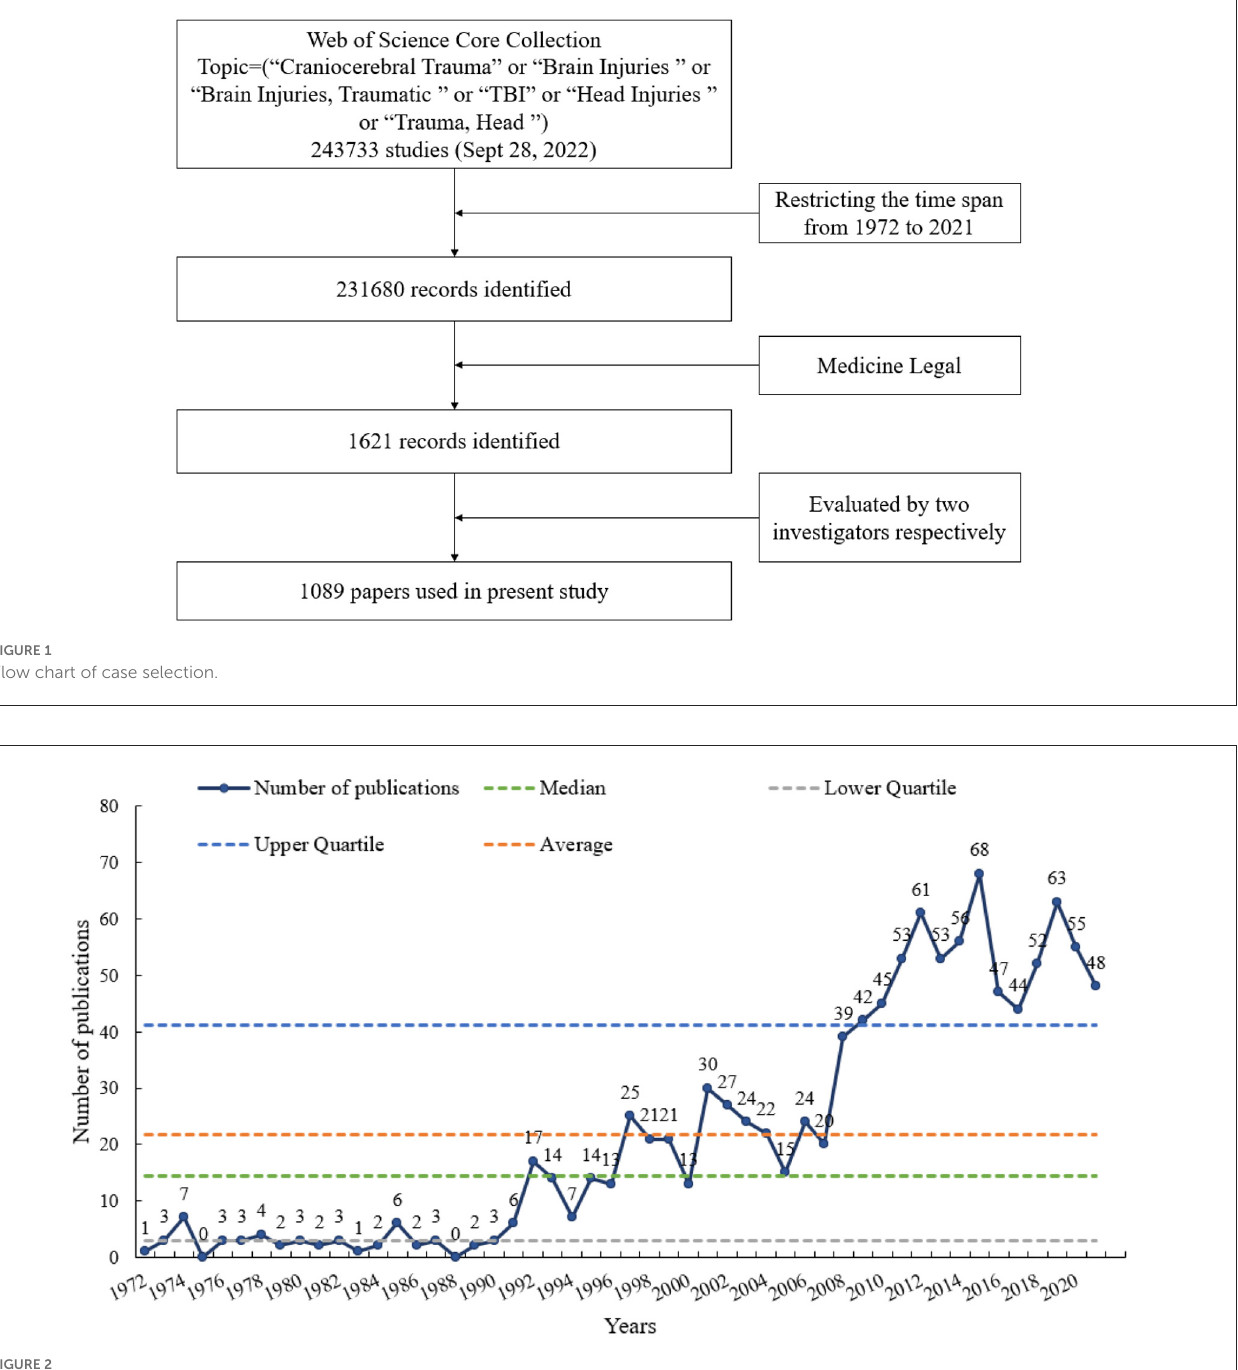
FIGURE2 Annual publication trends from 1972 to